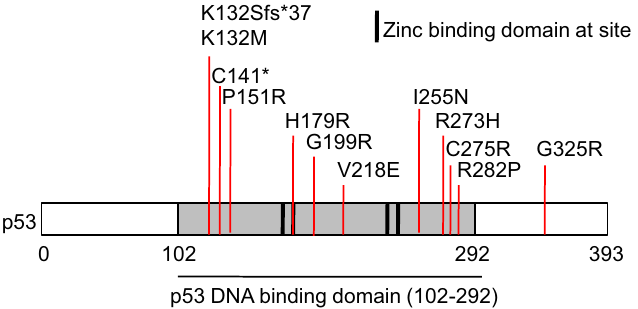
Figure 2. TP53 mutations in West China Hospital cohort of mantle cell lymphoma.